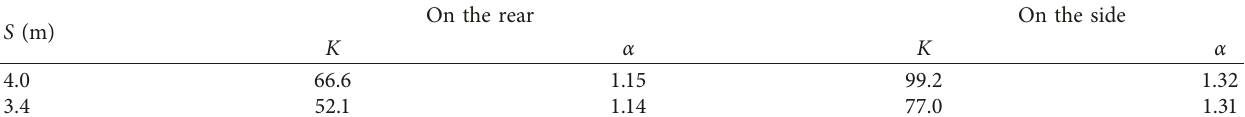
Figure 11: Relationships between vibration velocity of particles and equivalent distance. (a) Monitoring data in the rear and (b) monitoring data to the side. Table 5: Regression analysis results: particle vibration velocity predicted by empirical formula.